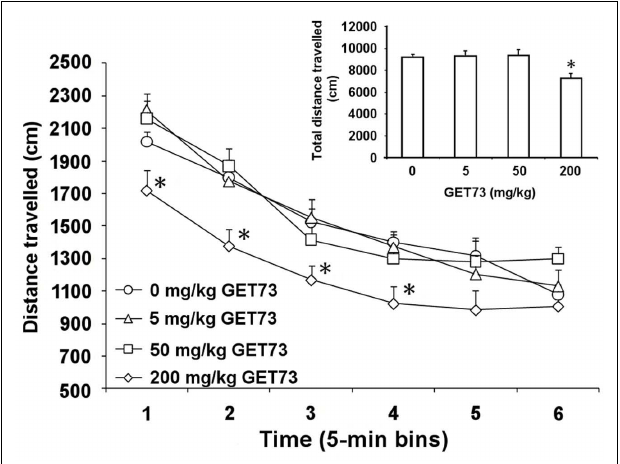
FIGURE 3 | Effect of theacute, intragastric administration of different doses of GET73 on spontaneous locomotor activity in Sprague-Dawley rats. GET73 was administered 30min before the start of the 30-min session. Data were recorded in six 5-min bins; total distance traveled over the 30-min session is reported in the inset. Each point or bar is the mean ± SEM of n = 8. * P < 0.05 with respect to 0-mg/kg GET73-treated rat group at the corresponding time (Newman–Keuls